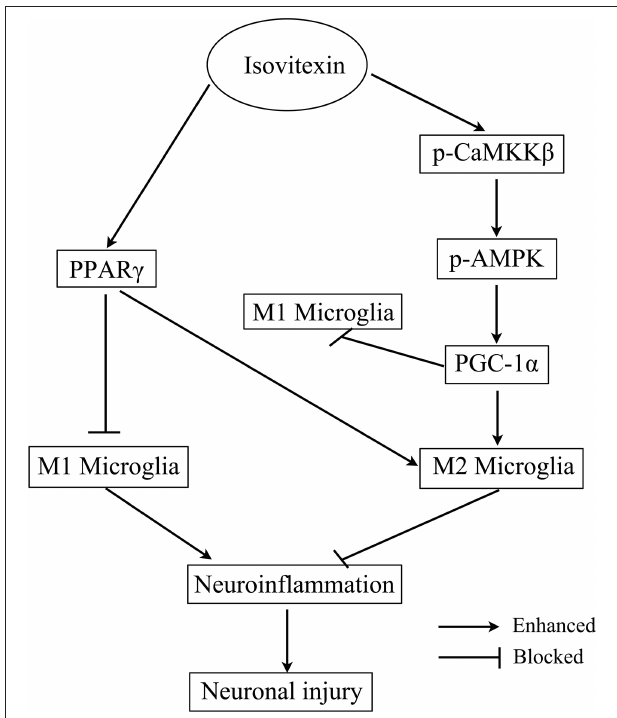
FIGURE 11 | Scheme for the proposed mechanisms of the anti-neuroinflammatory effects of Isovitexin. The mechanisms involve Isovitexin promoting microglia M2 polarization and inhibition of M1 polarization, and the activation of PPAR γ and CaMKK β /AMPK- PGC-1 α signaling